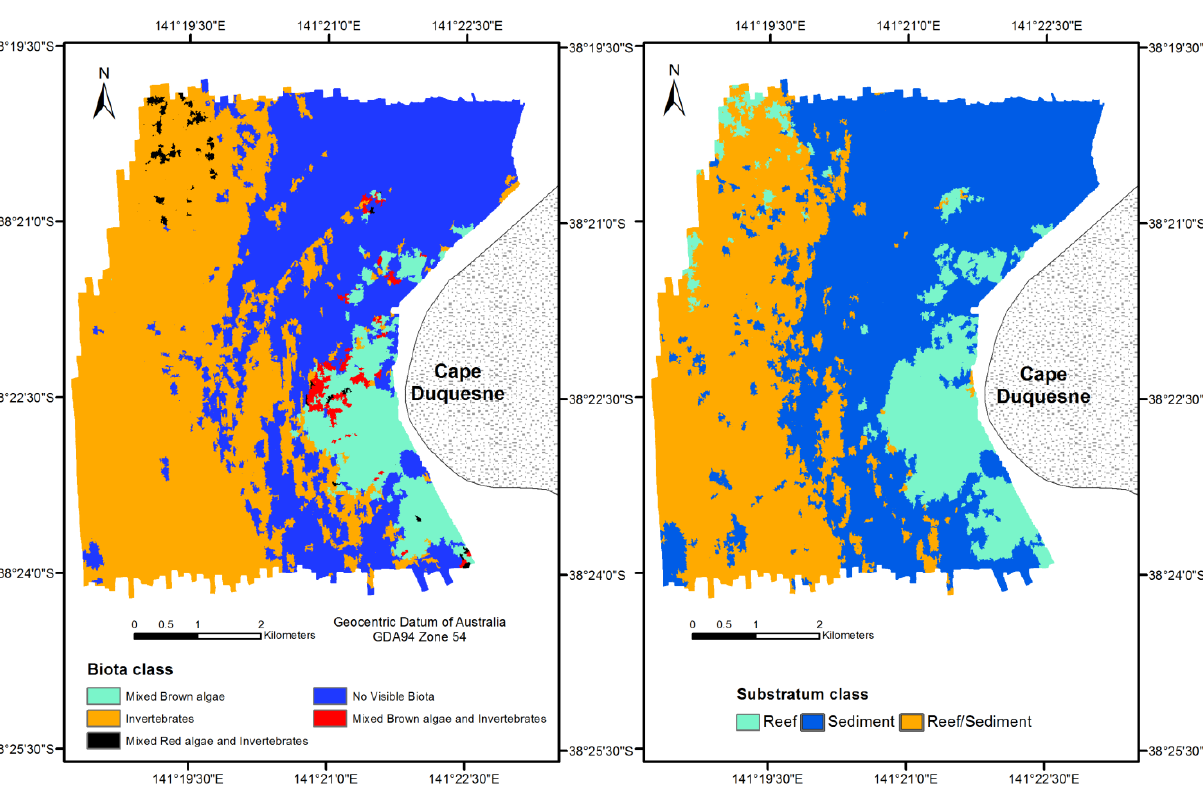
Figure 2. Habitat maps of biota and substratum classifications from the best model (the Support Vector Machine for biota and the Random Forest decision tree for